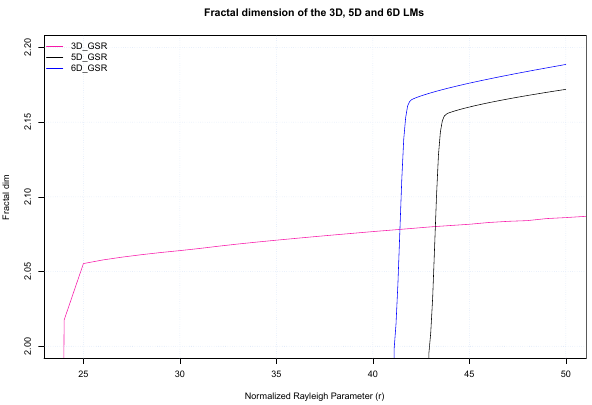
Figure A2. The Kaplan–Yorke fractal dimension of the 3-D, 5-D, and 6-D LMs as a function of the normalized Rayleigh number ( r